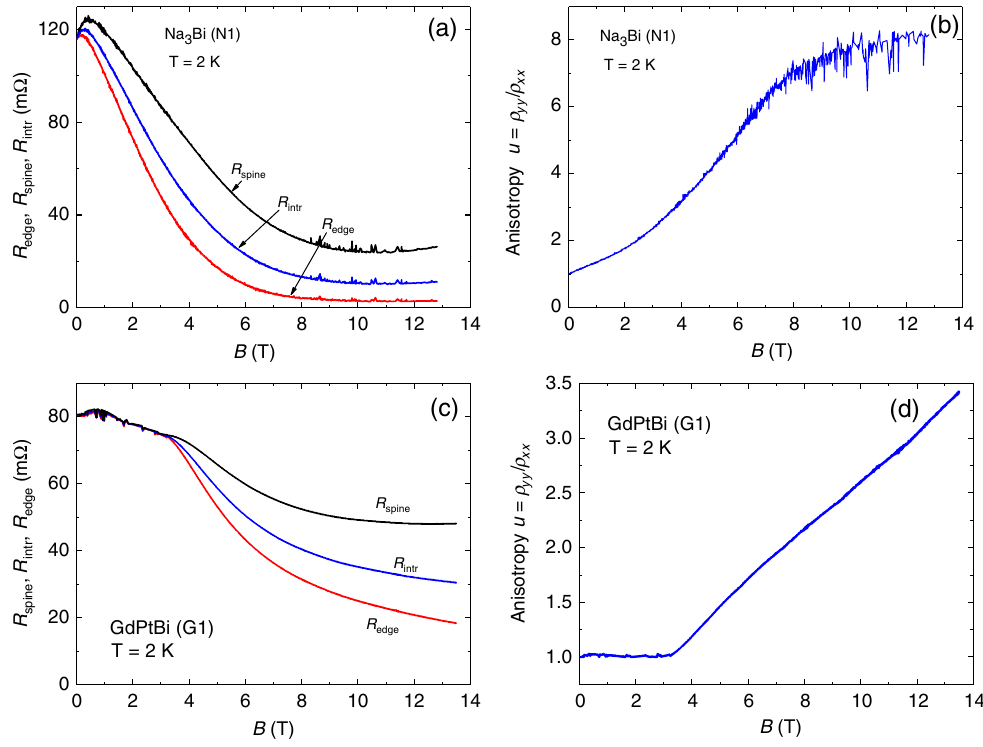
FIG. 4. The intrinsic field profiles of ρ xx ð B Þ and anisotropy u ð B Þ derived by applying Eqs. (12) – (14). Panel (a) shows the curves of R (black) and R (red) measured in Na 3 Bi at 2 K. The inferred intrinsic profile R (blue curve) is sandwiched between the spine edge intr measured curves. In this sample (N1), R decreases by a factor of 10.9 between B ¼ 0 and 10 T. We note that R displays a weak intr spine minimum near 10 T, which results from the competing trends in ρ xx ð B Þ and L s ð B Þ . Panel (b) displays the intrinsic u ð B Þ in Na 3 Bi derived ð B Þ in panel (c) is from Eq. (13). The corresponding curves for GdPtBi (sample G1 at 2 K) are shown in panels (c) and (d). Again, R intr ð B Þ and R ð B Þ . Panel (d) plots the intrinsic anisotropy u ð B Þ . In GdPtBi, the Weyl nodes only sandwiched between the curves of R edge spine appear when B is strong enough to force band crossing. In G1, this occurs at 3.4 T ( u remains close to 1 below this